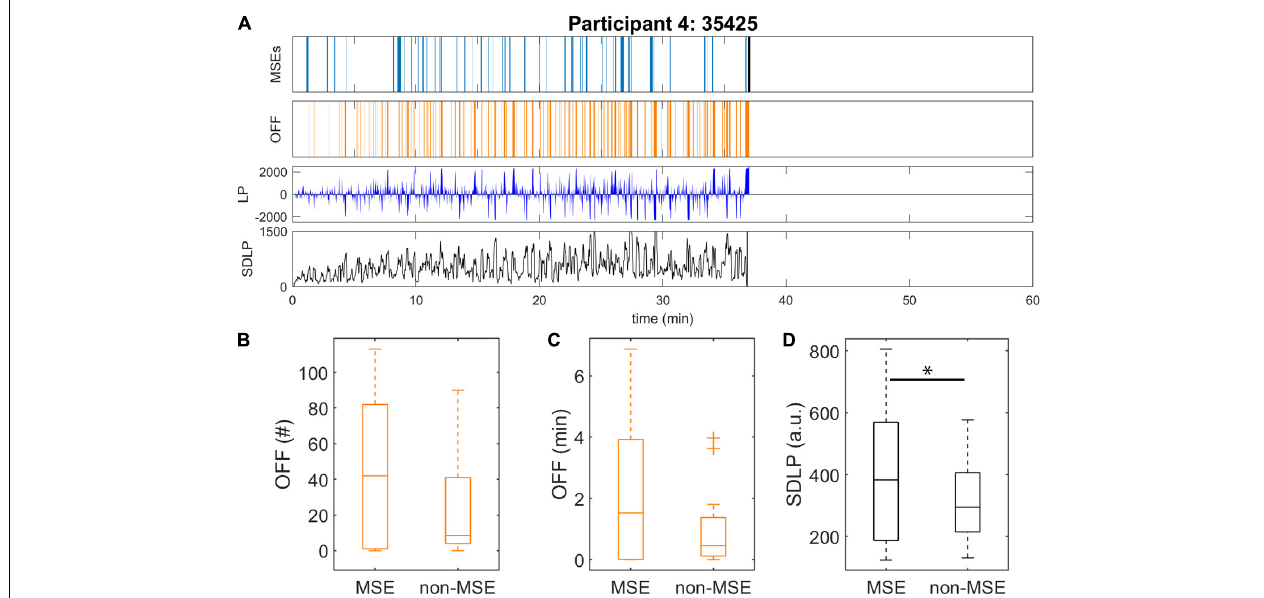
FIGURE 2 | Automatic detection of microsleep episodes (MSEs) and driving performance in the driving simulator after sleep deprivation. Data were analysed until sleep onset. (A) Displayed for one representative participant: automatically detected MSEs (light blue) with sleep onset (black bar), off-road events (OFF, orange), lateral car position (LP, dark blue; 0 = centre of the road, off-road > ± 1000) and standard deviation of lateral position (SDLP, black) calculated in a 10-s moving window. Driving performance and EEG derived MSEs might be 1–2 s out of synchronisation. Data of all participants are provided in Supplementary Figure S2 . Driving performance of all participants as measured by (B) number and (C) duration of off-road events (OFF), and (D) SDLP (10-s moving window), were calculated for the subsequent minute after each MSE onset (“MSE”), and the rest of the recording (“non-MSE”). ∗ Significant difference ( p <